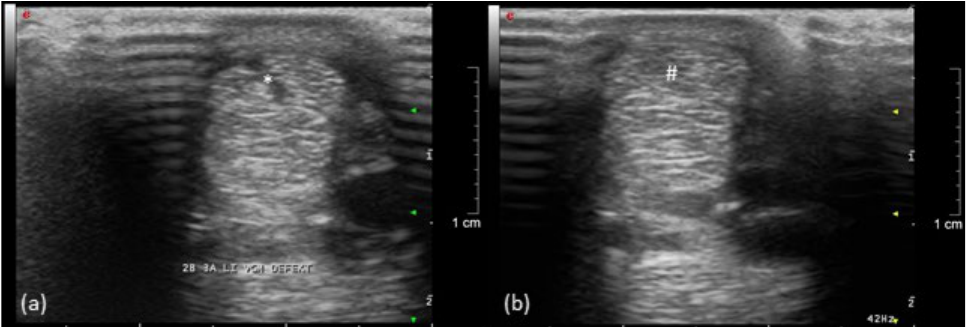
Figure 4. Ultrasonographic image of the left forelimb of a pony, left is lateral: ( a ) acute (*) and ( b ) healing (#) tendon lesion of the SDFT (9 weeks after injection of collagenase).